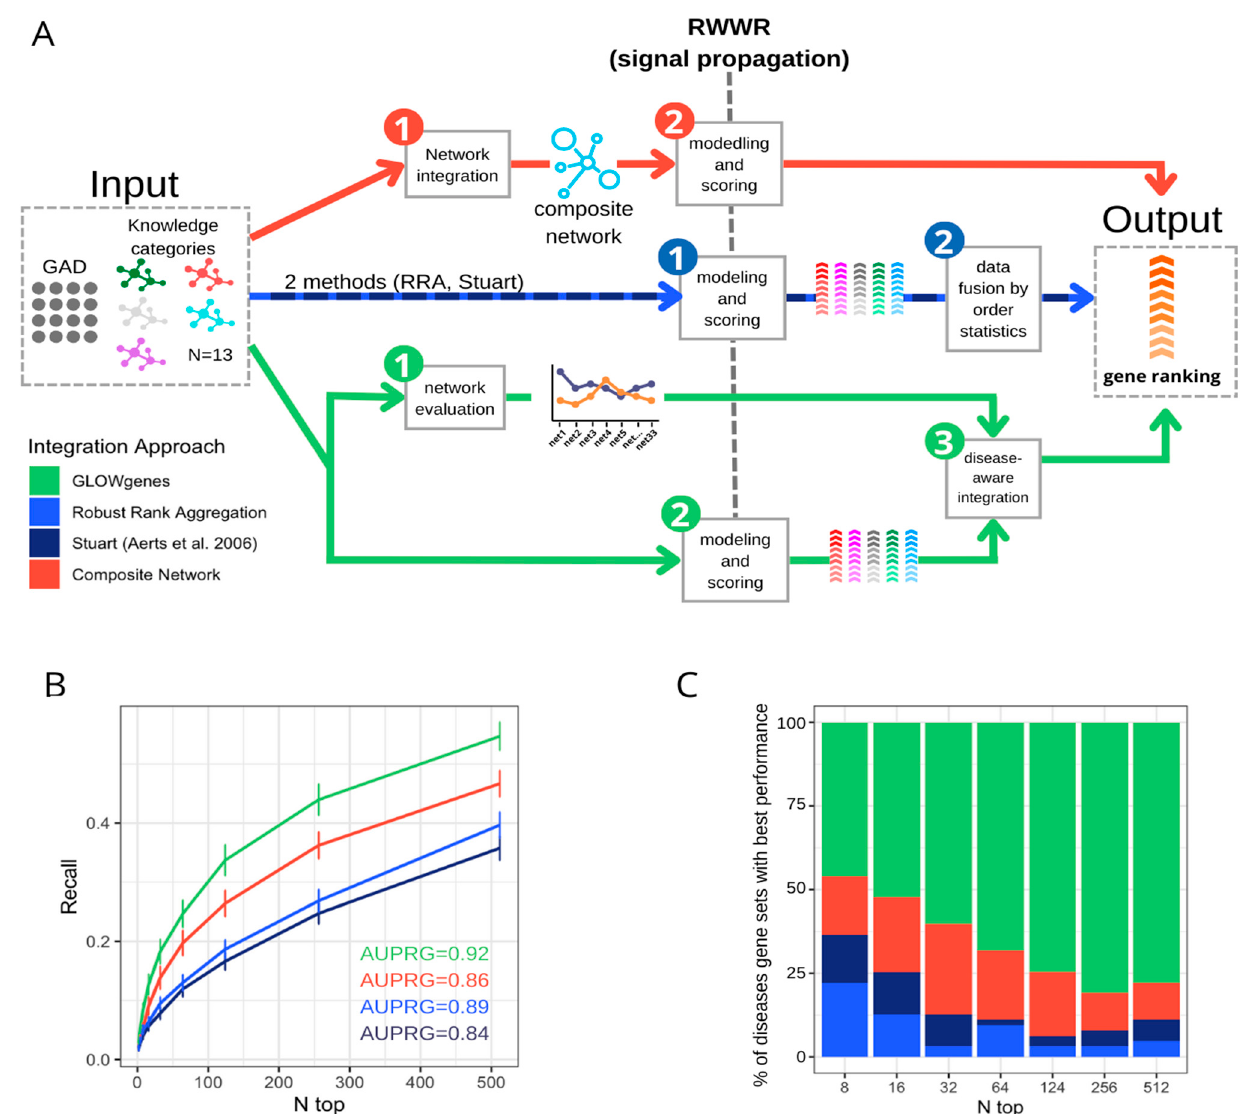
Figure 5. Benchmarking of three data integration approaches for disease candidate gene prediction. ( A ) General schema of three approaches for the integration of various datasets applied to the prior- itization of phenotype-associated genes. In red, the composite network approach first merged the available networks into a composite network, (1) that is the subject of the modeling and scoring step (2) to generate the gene ranking. In blue, the data fusion approach applies first modeling and scoring in every dataset (1) to merge them into a unique ranking using order statistics (2). In green, GLOW- genes approach takes two steps, the evaluation of the performance of every network (1) and the modeling and scoring of the networks producing a ranking for each one (2). In a third step, (1) and (2) are merged to produce a single gene ranking (3). ( B ) Recall at various n-top of the performance